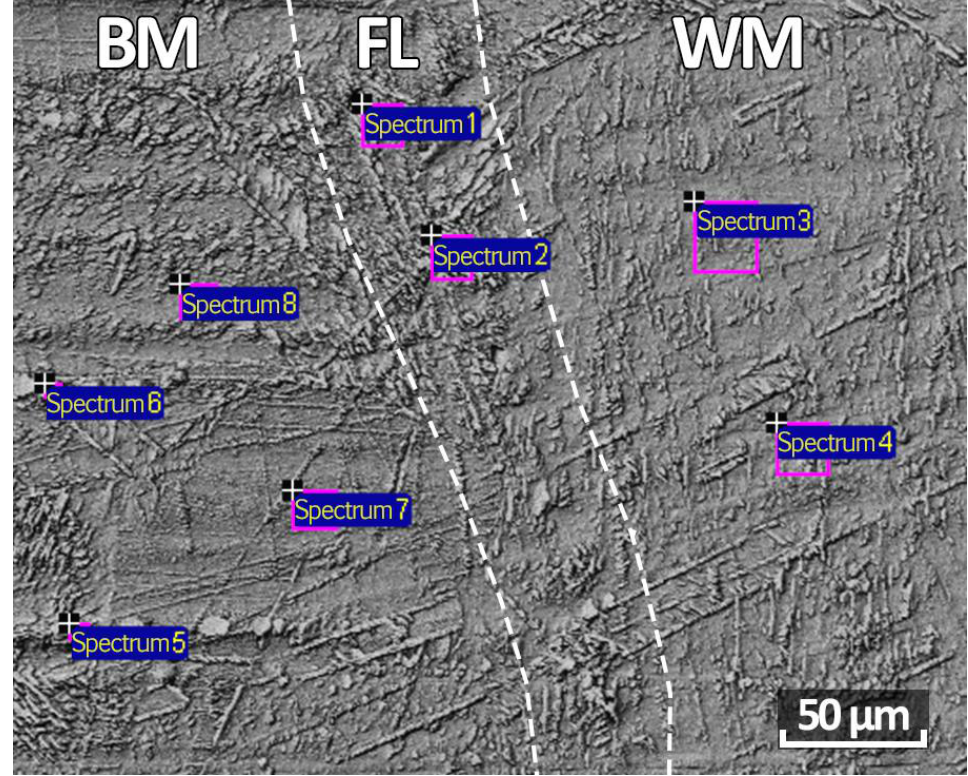
Figure 7. Points of the spectra of a HT_2 sample.